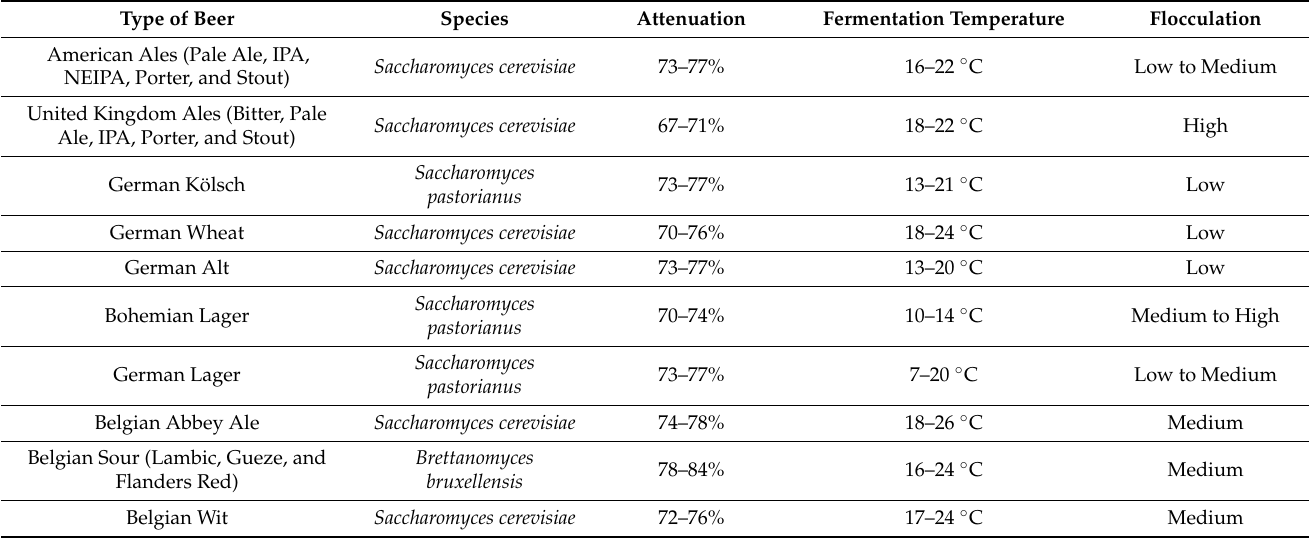
Table 1. Various types of yeast, their important properties for brewing beer, and the type of beer *.